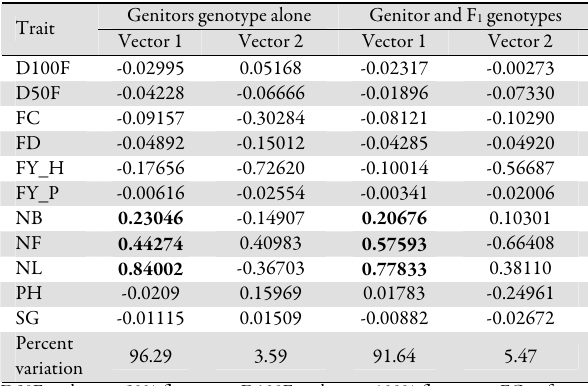
Table 2. Principal component analysis (PCA) on the agronomic traits of eggplant genitors and genitor/F 1 genotypes